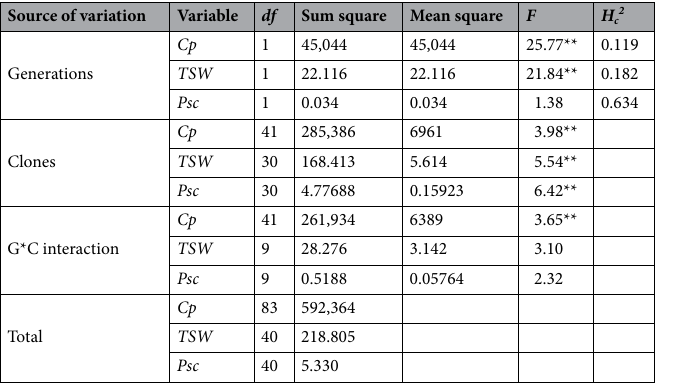
Table 4. Analysis of variance for seed production among generations and clones in the seed orchards of Chinese fir. Cp cone production, TSW thousand seed weight, Psc seed production of one cone.